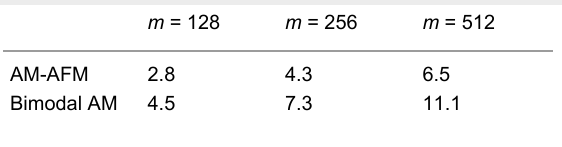
Table 2: Comparison between two different numerical integration algo- rithms, LSODA and RK-4. The numbers indicate the factor by which LSODA is faster than RK-4 for two dynamic AFM configurations (see Table 1); m is the number of points per period to represent the oscilla-